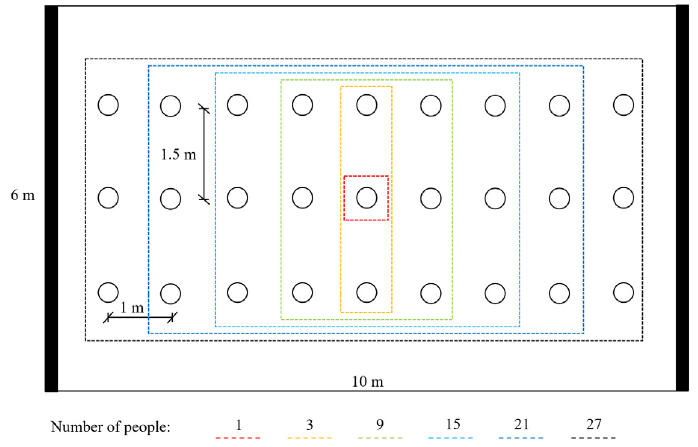
Figure 4. Position of the bouncing people in the crowd in the numerical example